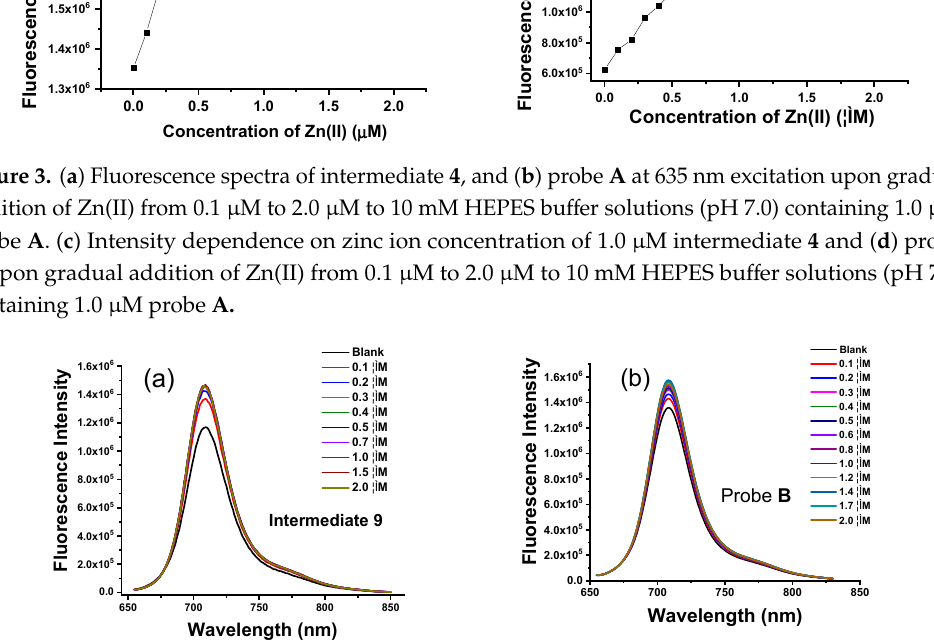
Figure 4 . (a) Fluorescence spectra of 1.0 μ M intermediate 9 and (b) probe B at 635 nm excitation upon gradual addition of Zn(II) from 0.1 µ M to 2.0 µ M to 10 mM HEPES bu ff er solutions (pH 7.0) containing gradual addition of Zn(II) from 0.1 μ M to 2.0 μ M to 10 mM HEPES buffer solutions (pH 7.0) 1.0 µ M probe B containing 1.0 μ M probe B .